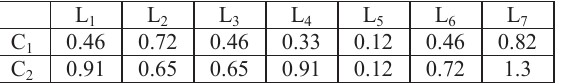
Fig 4. user label priority